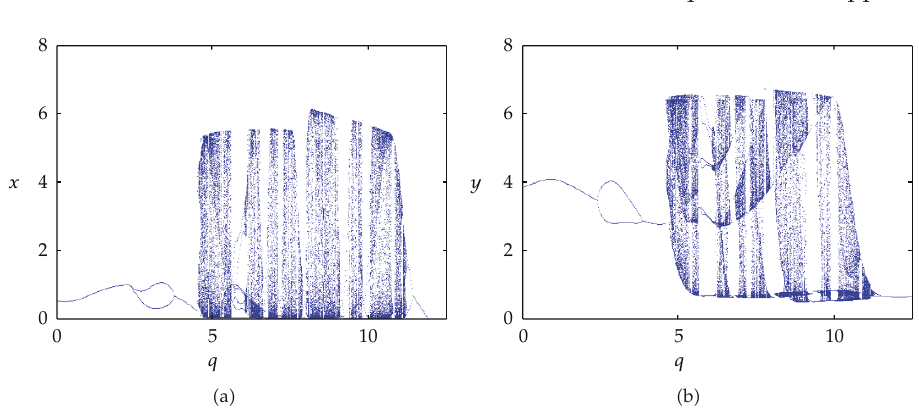
Figure 3: Bifurcation diagrams of (cid:3) 1.3 (cid:4) for q ranging from 0 < q < 13. (cid:3) a (cid:4) x is plotted. (cid:3) b (cid:4) y is